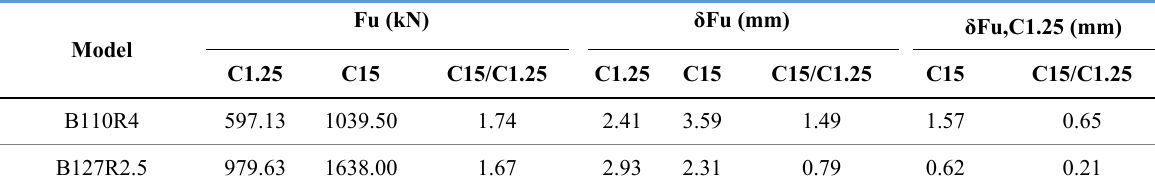
Table 7. Failure loads and displacements of models C1.25 and C15 Model